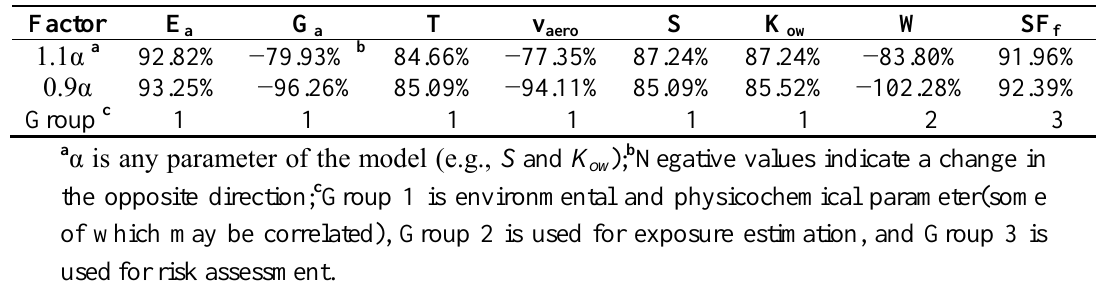
Table 3. Results of relative sensitivity